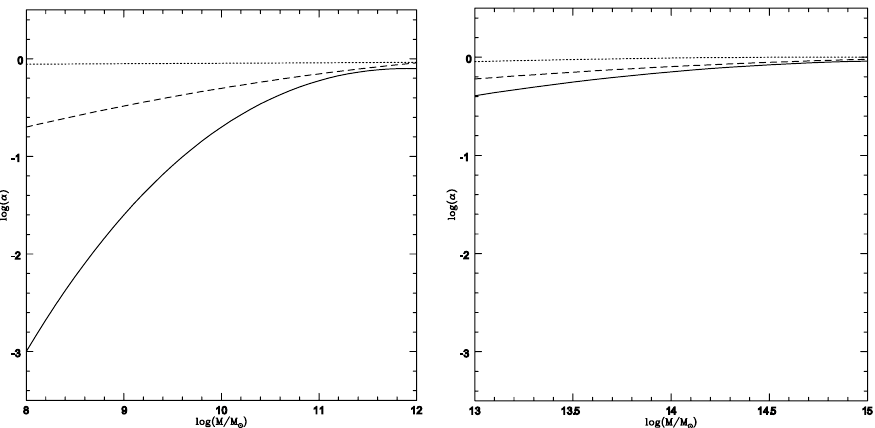
Fig. 2. The inner density slope as a function of halo mass. Panel (a): the solid, dashed and dotted lines represent the results of the model of the present paper for the cases A, B and C described in the text. Panel (b): the same as in (a) but for groups and clusters of